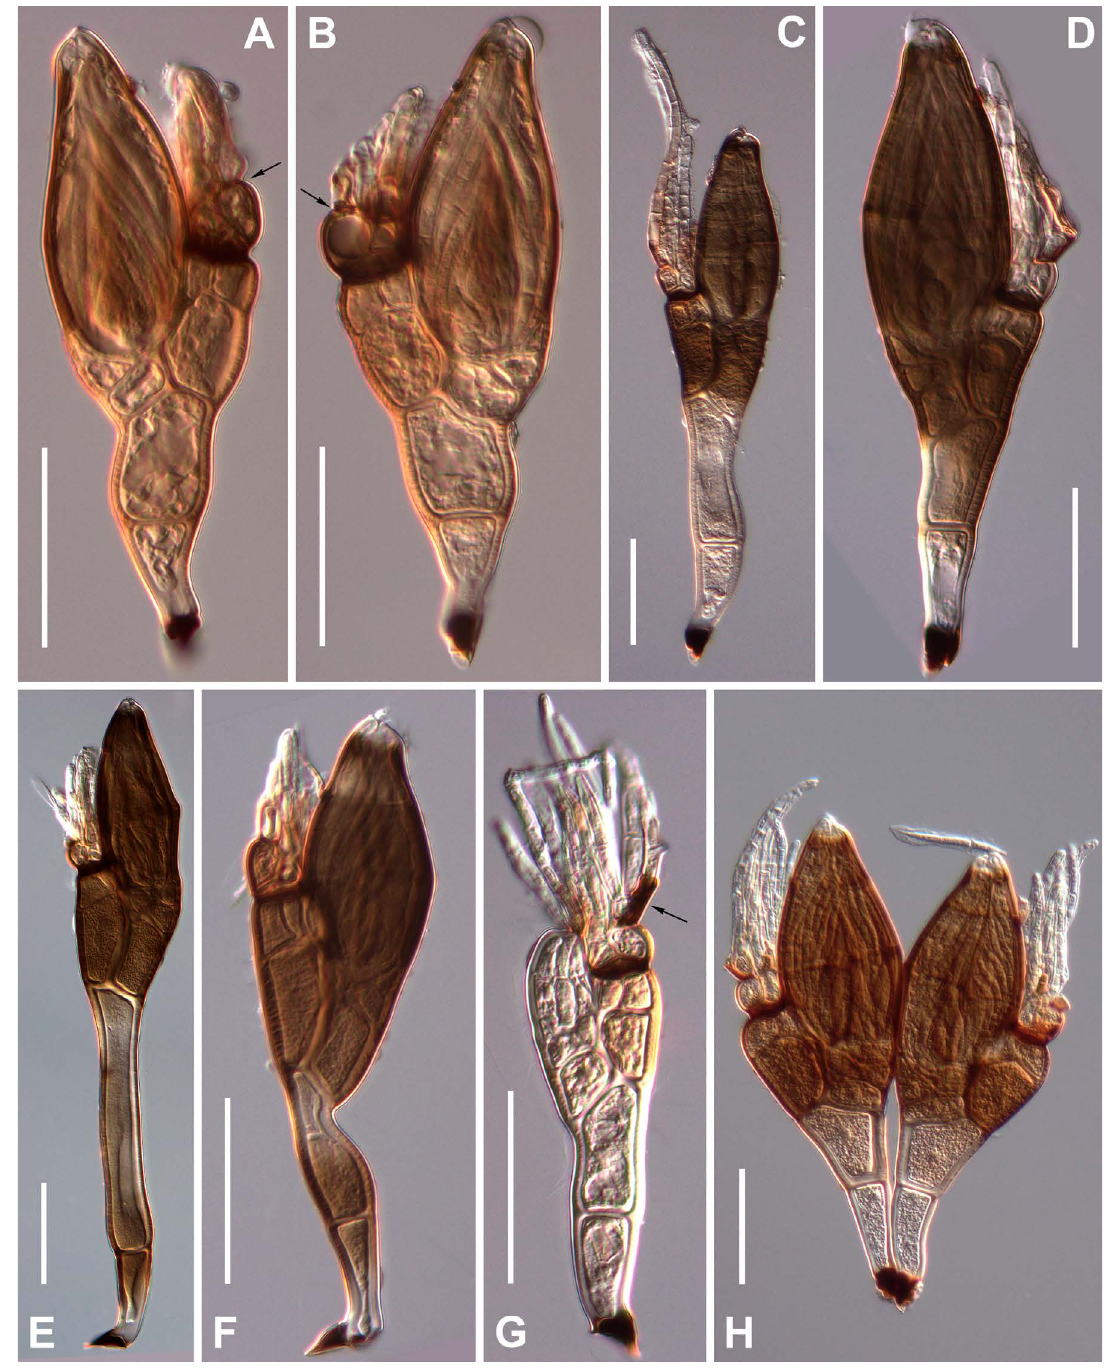
Fig. 40. Laboulbenia spp. A – B . L. parriaudii Balazuc ex Santam. Mature thalli showing the distal septum of the basal cell darkened and constricted (arrows), a diagnostic character. – C – H . L. pedicellata Thaxt. Mature thalli, except the immature one represented in G showing the septum at the lower side in outer branch thick and dark, with blackened suffusion spreading through the dorsal margin (arrow). C – D . From Bembidion aeneum . E . From Bembidion doris . F . From Bembidion minimum . G – H . From Bembidion mannerheimi . Scale bars: 50 µm. Photographs from slides ZMUC C-F-124096 (A–B), ZMUC C-F-122506 (C–D), ZMUC C-F-122492 (E), ZMUC C-F-123118 (F), ZMUC C-F-123132 (G), ZMUC C-F-123391